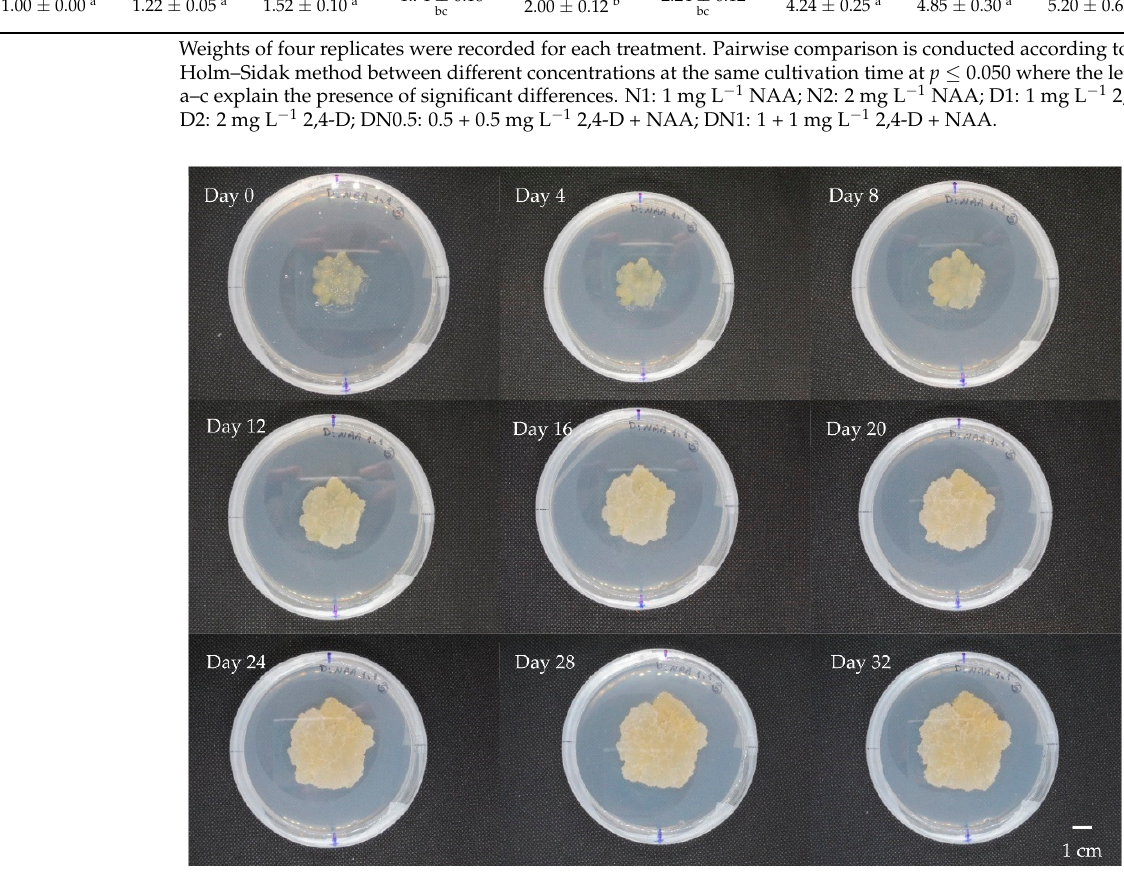
Figure 3. Dynamics of L. schweinfurthii callus growth during 32 days at 4-days intervals cultured on MS medium supplemented with 2,4-D and NAA of 1 mg L − 1 concentration each (DN1). The changes in the size of the callus have been observed in terms of the callus area.